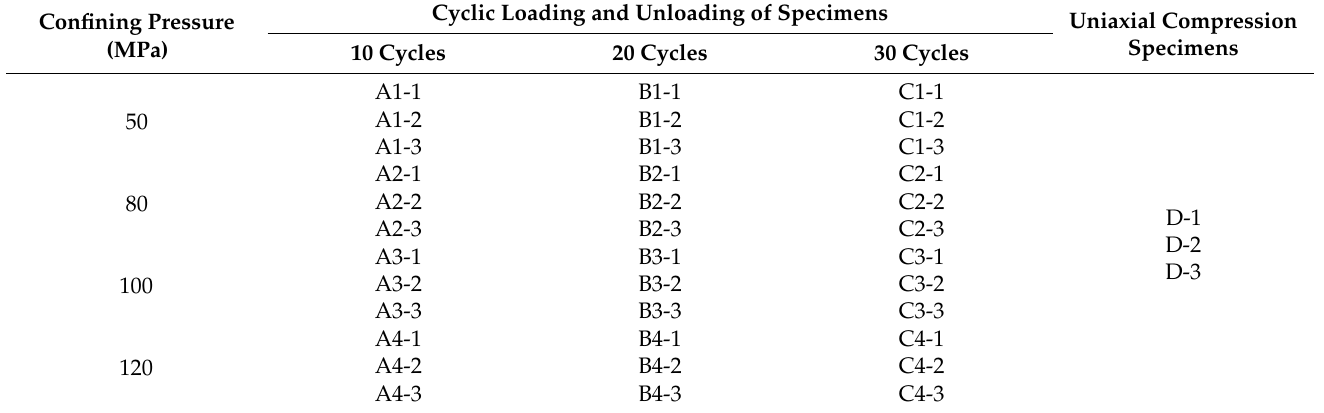
Table 2. Specific scheme of pre-damage